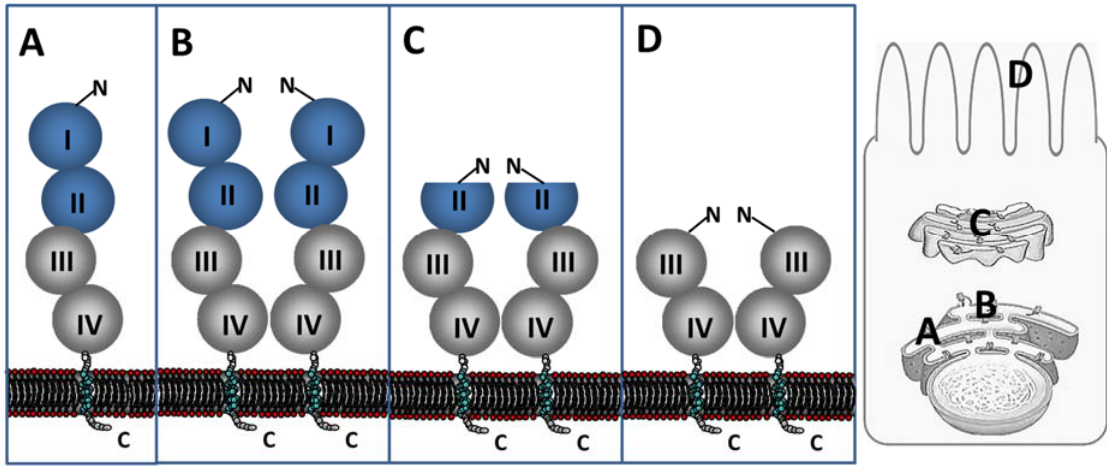
Figure 1. Maturation steps of lactase-phlorizin hydrolase (LPH) in the intestinal epithelial cells. ( A ) The protein is synthesized as a monomeric pro-LPH molecule by translocation in the endoplasmic reticulum (ER). LPH is a type I transmembrane glycoprotein, which consists of a luminal C -terminus, a membrane anchor and an ectodomain with four highly- conserved structural and functional domains and an extracellular N -terminus. In the ER, the polypeptide is N -glycosylated, which is required for the correct folding of the protein. ( B ) Prior to its exit from the ER, pro-LPH molecules form homodimers, which are required for the acquisition of transport-competence and enzymatic activity. ( C ) After transport to the Golgi apparatus, pro-LPH is cleaved in the trans -Golgi network, which leads to the removal of LPH α , leaving LPH β initial . In addition, LPH is further N - and O -glycosylated, which is crucial for the correct folding, and subsequently, for the enzymatic activity of the